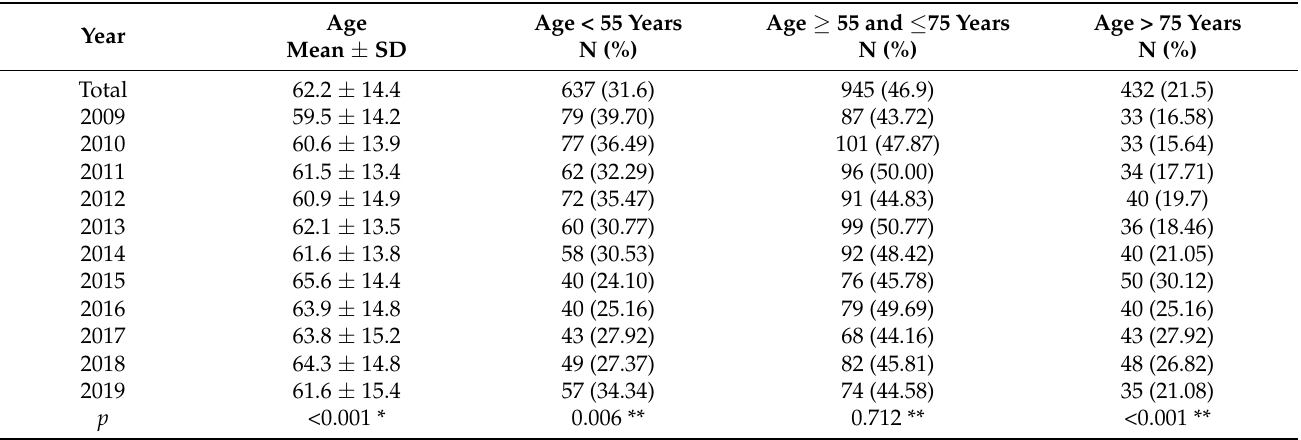
Table 2. The number of hospitalizations due to SAH according to age category in the Silesian Province between 2009 and